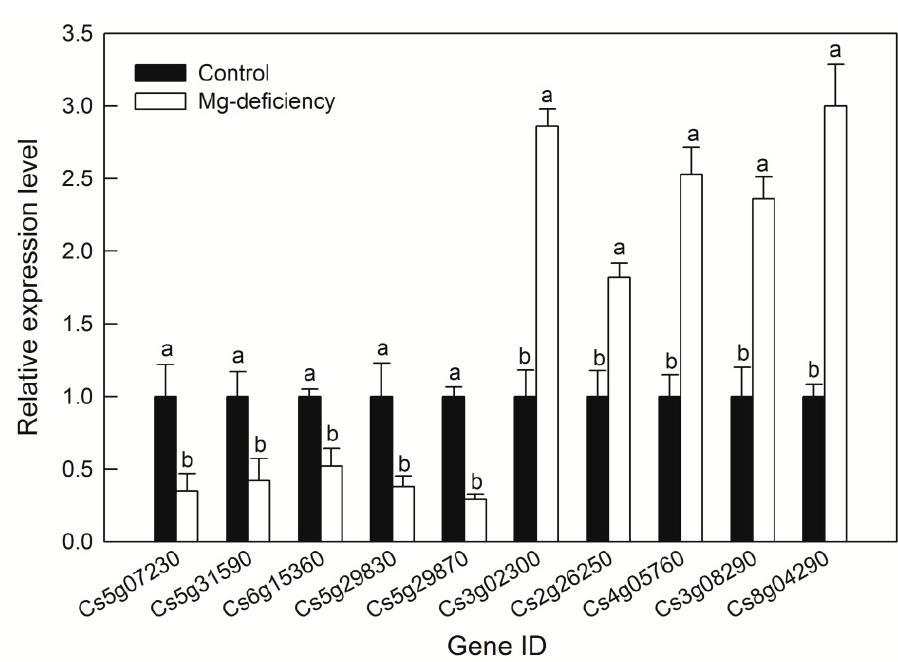
Figure 5. Relative expression levels of ten DEGs under Mg deficiency in C. sinensis leaves. Cs5g07230: Cs5g07230: cytochrome P450; Cs5g31590: tRNA delta (2)-isopentenyl pyrophosphate transferase; Cs6g15360: dehydration-responsive element-binding protein 1B; Cs5g29830: MYB4; Cs5g29870: ethylene-responsivetranscriptionfactor1B;Cs3g02300: helicaseSEN1; Cs2g26250: